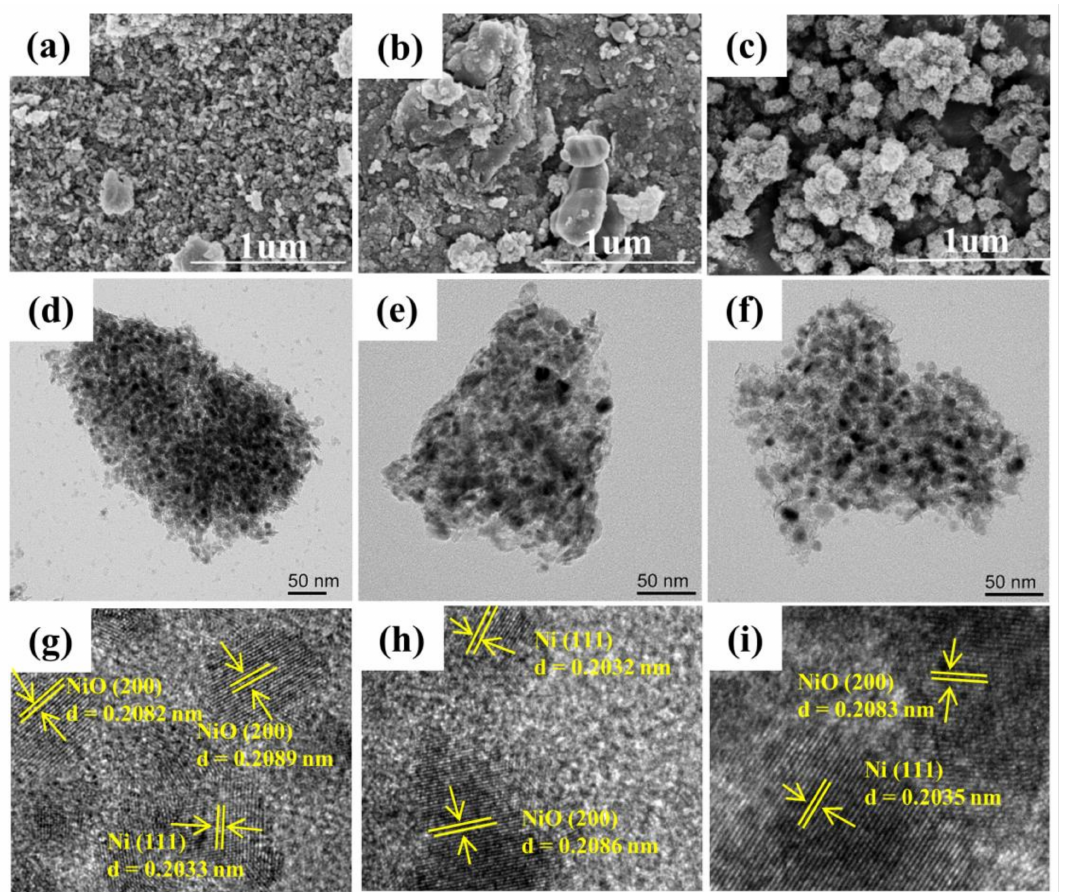
Figure 2. Scanning electron microscopy images of ( a ) H-NiAl-LDO, ( b ) H-SiCl 4 -NiAl-LDO, and ( c ) H-SiO 2 -NiAl-LDO; Transmission electron microscopy (TEM) images of ( d ) H-NiAl-LDO, ( e ) H- SiCl 4 -NiAl-LDO and ( f ) H-SiO 2 -NiAl-LDO and High-resolution TEM images of ( g ) H-NiAl-LDO, ( h ) H-SiCl 4 -NiAl-LDO, and ( i ) H-SiO 2